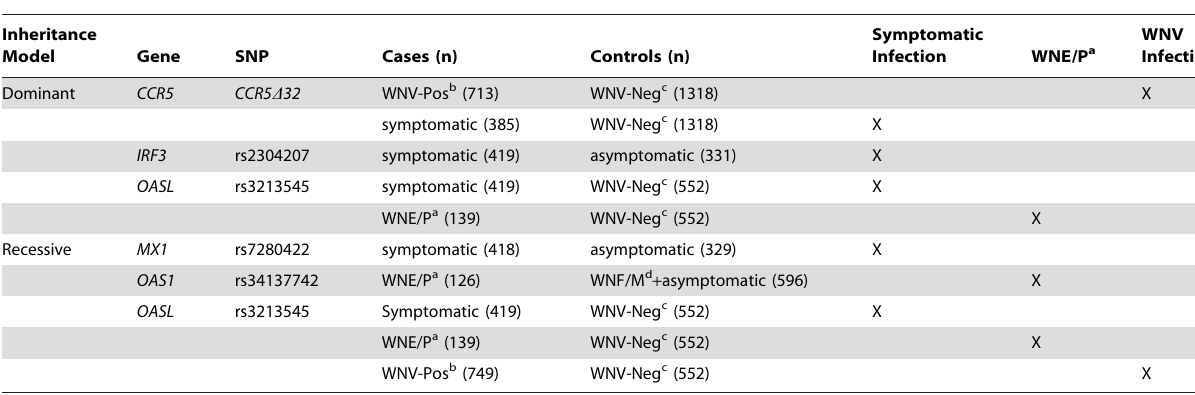
Table 5. Summary of significant